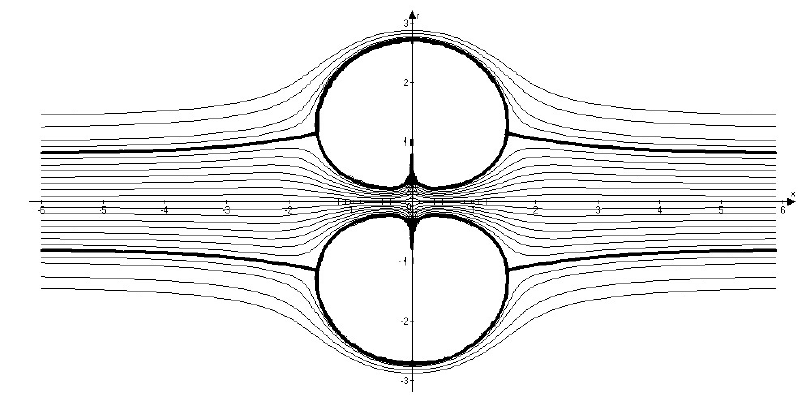
Figure 4: The streamline along a toroidal solid.